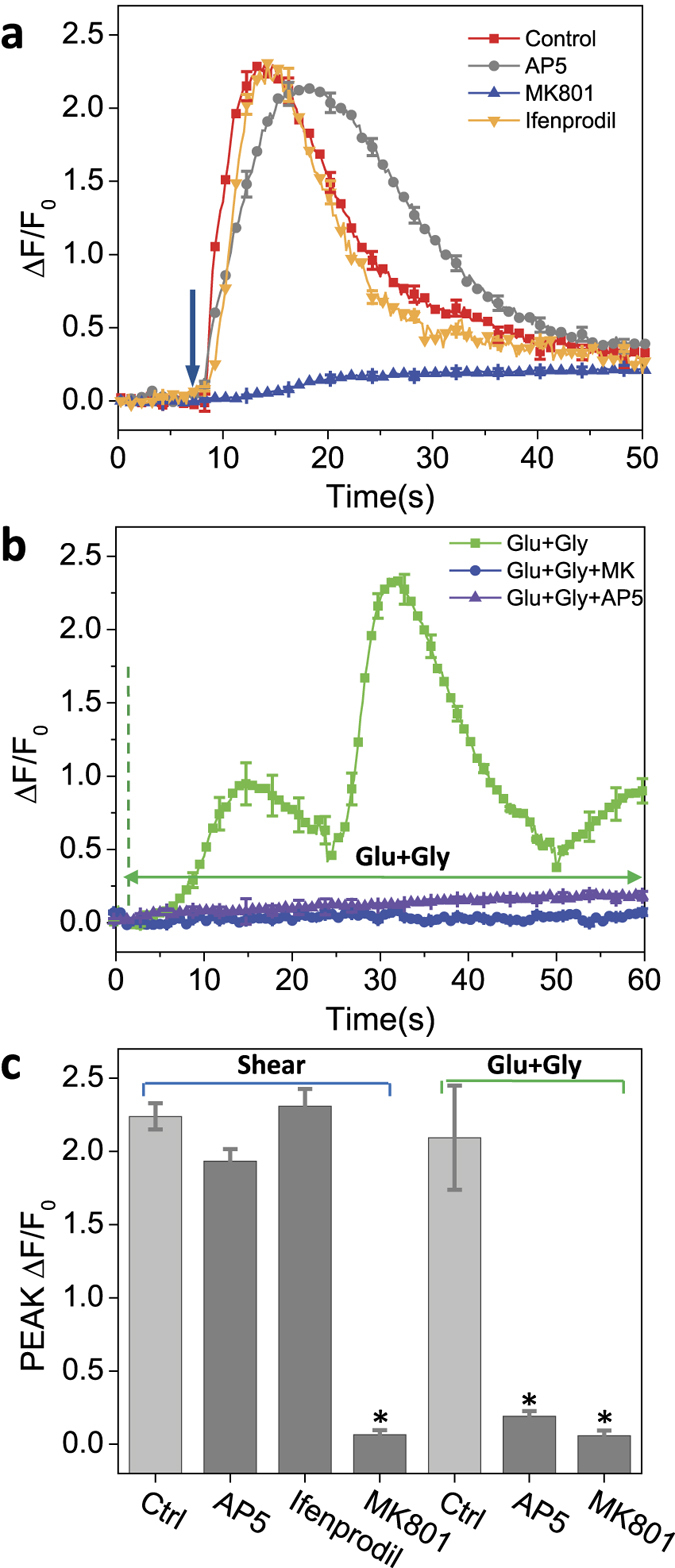
Role of free glutamate and glutamate binding sites on shear induced Ca2+ response in astrocytes.(a) Ca2+ response to shear pulse stimuli (23 dyn/cm2, 10 ms) in control (red), AP5 (50 μM, Gray), IFN (10 μm, orange), and MK-801 (50 μM, Blue) showing that blocking glutamate binding sites did not affect the Ca2+ response to shear. (b) Ca2+ response to agonists (1 mM glutamate and 1 mM glycine) in control (green), AP5 (200 μM), and MK-801 (50 μM). Each curve was an average of 200 cells from 4 experiments (*p < 0.05). (c) Peak Ca2+ intensity with and without glutamate inhibitors. Error bars indicate s.e.m.